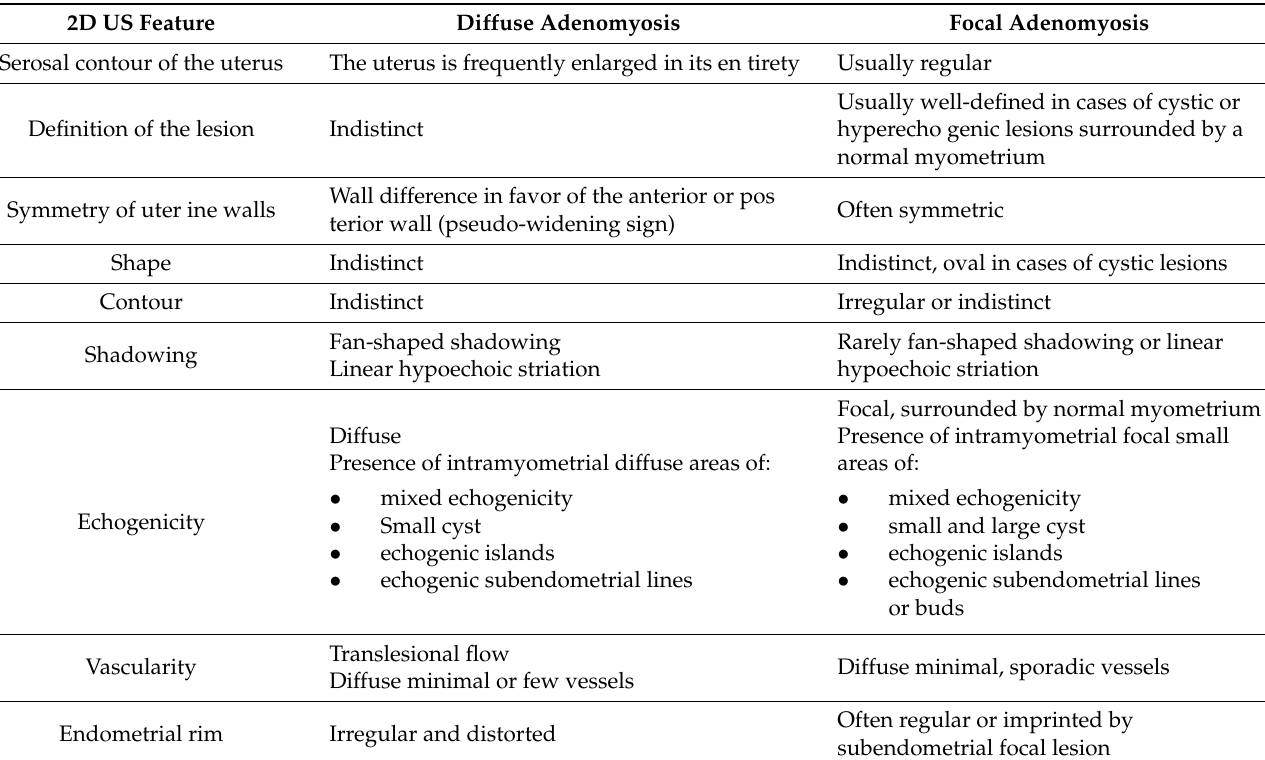
Table 2. Ultrasound features of diffuse and focal adenomyosis